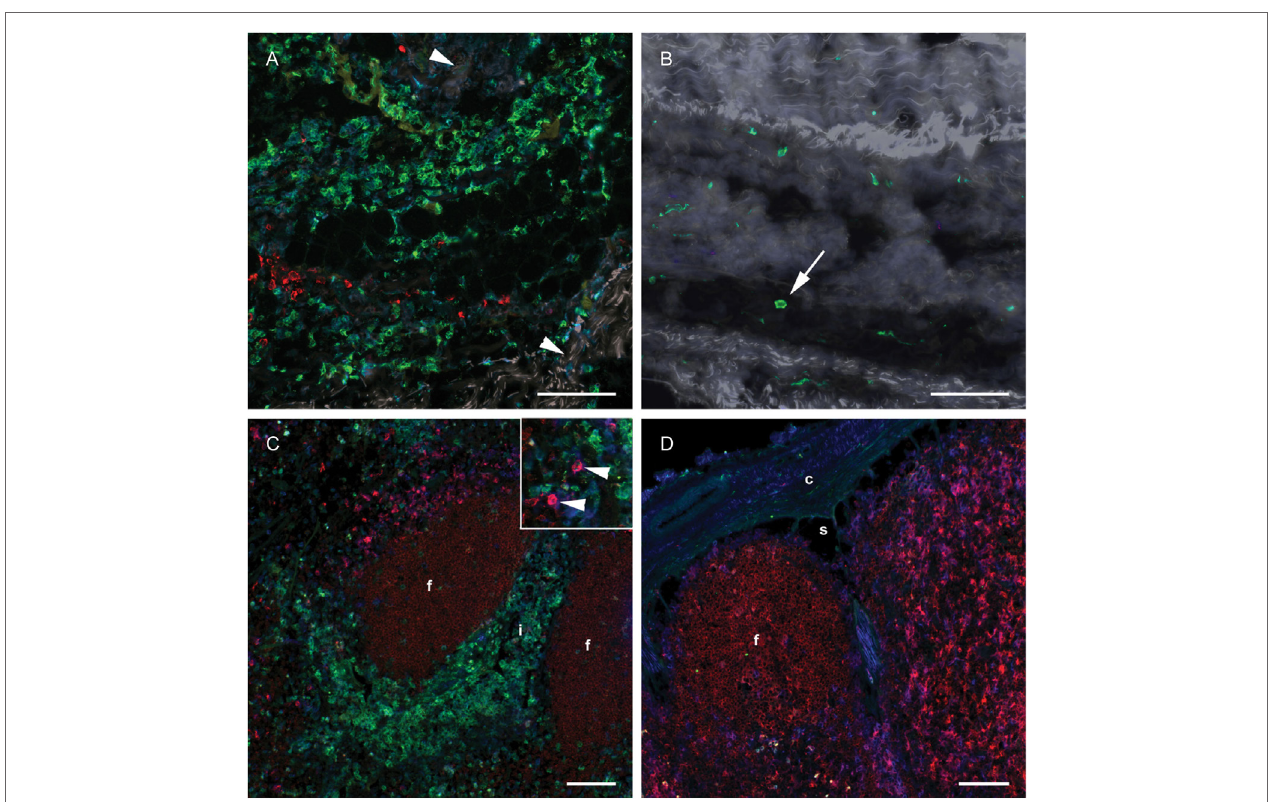
FigUre 6 | Distribution of monocyte and Dc markers in skin and lns . Immunofluorescent labeling of subcutaneous tissues and LNs with antibodies against CD14 (green), CD205 (red) and CD11c (blue), at 24 h post-injection. (a) Large numbers of CD14 + cells were observed in the subcutis on the injected side. Note the separation of collagen bundles (appears as gray auto fluorescence, arrowheads) due to inflammatory infiltrates. A limited number of CD205 + cells were present. (B) A few CD14 + cells (arrow) were observed on the contralateral side. (c) CD14 + cells infiltrated the interfollicular areas of the cortex of the draining LN. A moderate amount of CD205 + CD11c + DCs were observed (arrow heads in insert). (D) CD14 + cells were sparsely present in the contralateral LN. CD205 + follicles were surrounded by CD11c single labeled and CD11c + CD205 + double labeled cells. Follicle (f), interfollicular area (i), capsule (c), sinus area (s). Scale bars: 100 μ